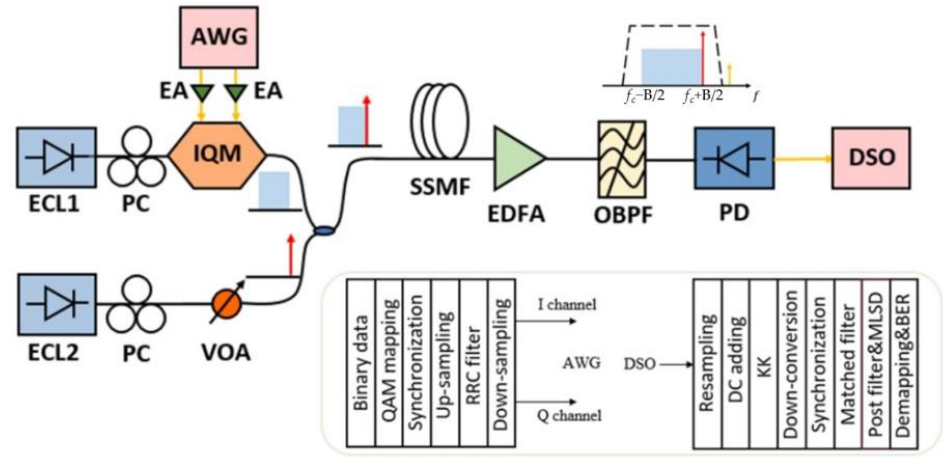
Figure 2. Experiment setup and DSP. Here, ECL: external cavity laser; PC: polarization controller; IQM: in-phase and quadrature modulator; AWG: arbitrary waveform generator; VOA: variable optical attenuator; EDFA: erbium-doped fiber amplifier; OBPF: optical bandpass filter; DSO: digital storage oscilloscope.